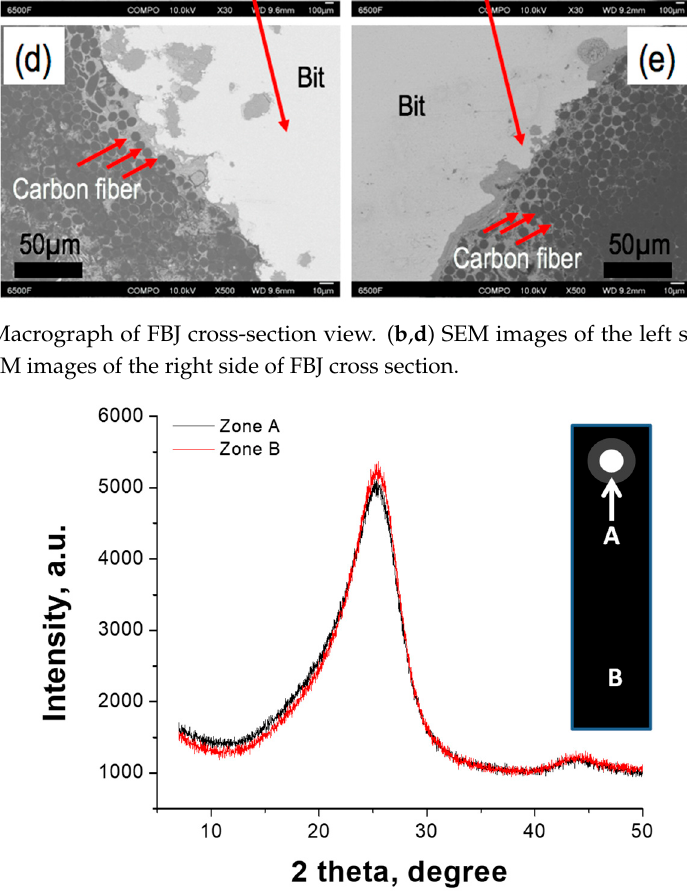
Figure 11. X-ray diffraction patterns measured the indicated area of lap joint. Zone A: thermally affected area shown in Figure 6a. Zone B: as-received CFRP.